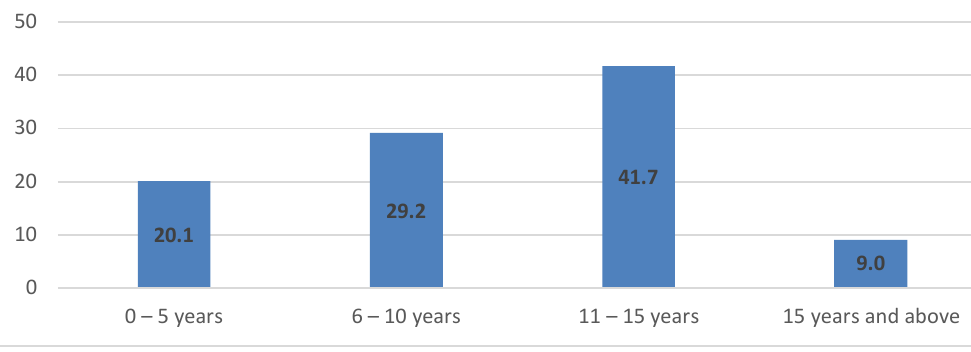
Figure 6: Board Member Experience of The Respondents; Source: Survey Data (2023)